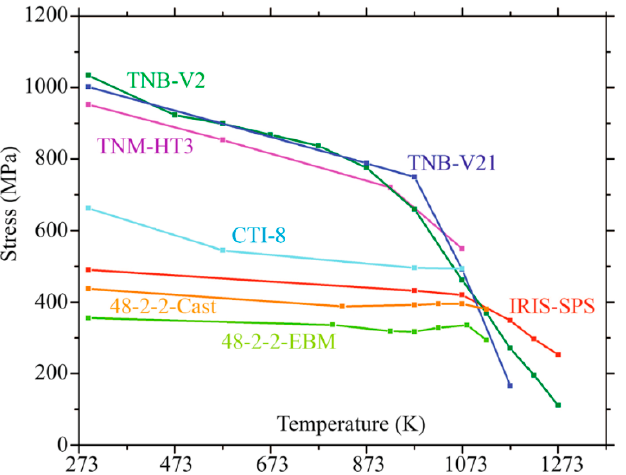
Figure 8. Variation of the yield stress as a function of temperature of the TiAl IRIS alloy elaborated by SPS, compared with that of alloys elaborated by other techniques (TNM-HT3: forging, TNB-V2, TNB-V21 and CTI-8: extrusion, 48-2-2: casting, 48-2-2-EBM: electron beam melting) [33]. Repro- duced with permission from Metallurgical and Materials Transactions: A , published by Springer Na- ture, 2016.